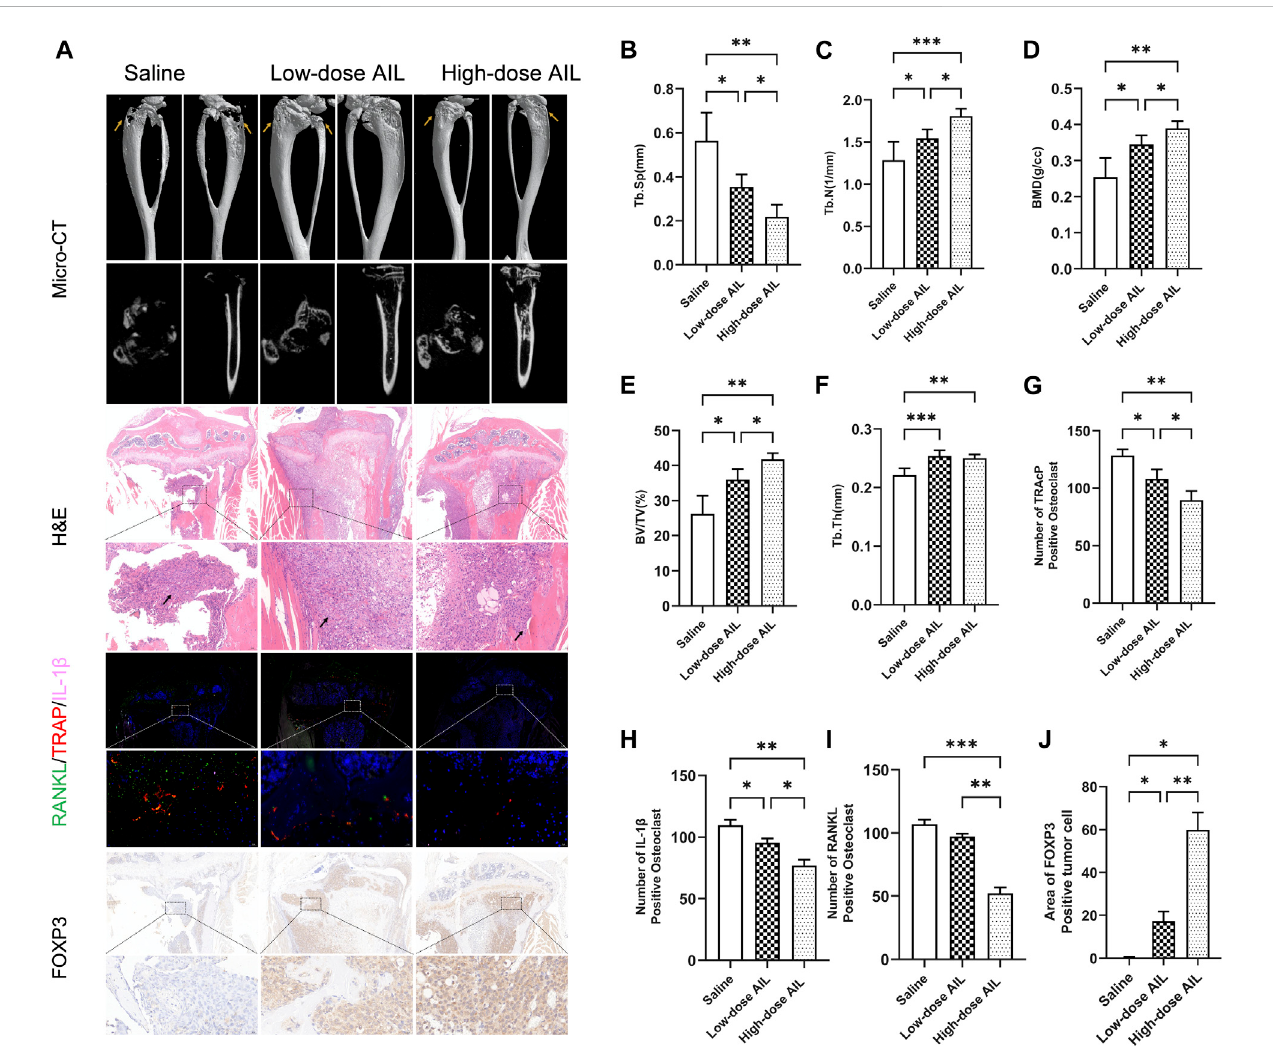
AILcontrolsRANKLandIL-1 β releasedbyBCcellsthroughFOXP3proteinexpression invivo topreventosteoclastdevelopmentandbonemetastases. (A) 3DreconstructionofmicroCT,H&E,biologicalstainingofRANKL(green),TRAP(red),andIL-1 β (pink)inthetibiastissueofmiceinthetumor-bearinggroupsof BC, and representative images of the FOXP3 immunohistochemical staining results. The osteolytic lesion area is indicated by the yellow arrow, while the tumor area is indicated by the black arrow. (B – F) BV/TV, BMD, Tb. Th, Tb. Sp, and Tb. N. The quantitative analysis was carried out using the μ CT Skycan CTAn software. The mean ± SD were used to express all the data. * p < 0.05, ** p < 0.01, *** p < 0.001. (G – I) The TRAP, IL-1 β and RANKL were quantitatively analyzed in proximal tibia of mice in the normal saline and AIL treatment groups (J) The FOXP3 positive cells were quantitatively analyzed in proximal tibia of threemicegroups.Themean±SDwereusedtoexpressallthedata.* p < 0.05,** p < 0.01,*** p < 0.001.Magni fi cationof5×/20×(left/right,H&E),5×/40×(left/ right, IF), 5×/40× (left/right, FOXP3